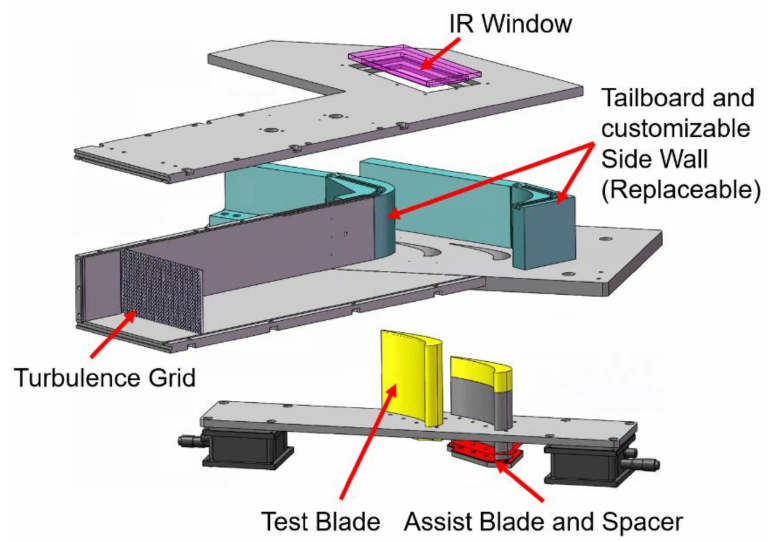
Figure 10. Detailed 2-Passage mechanical design of 2-Passage linear